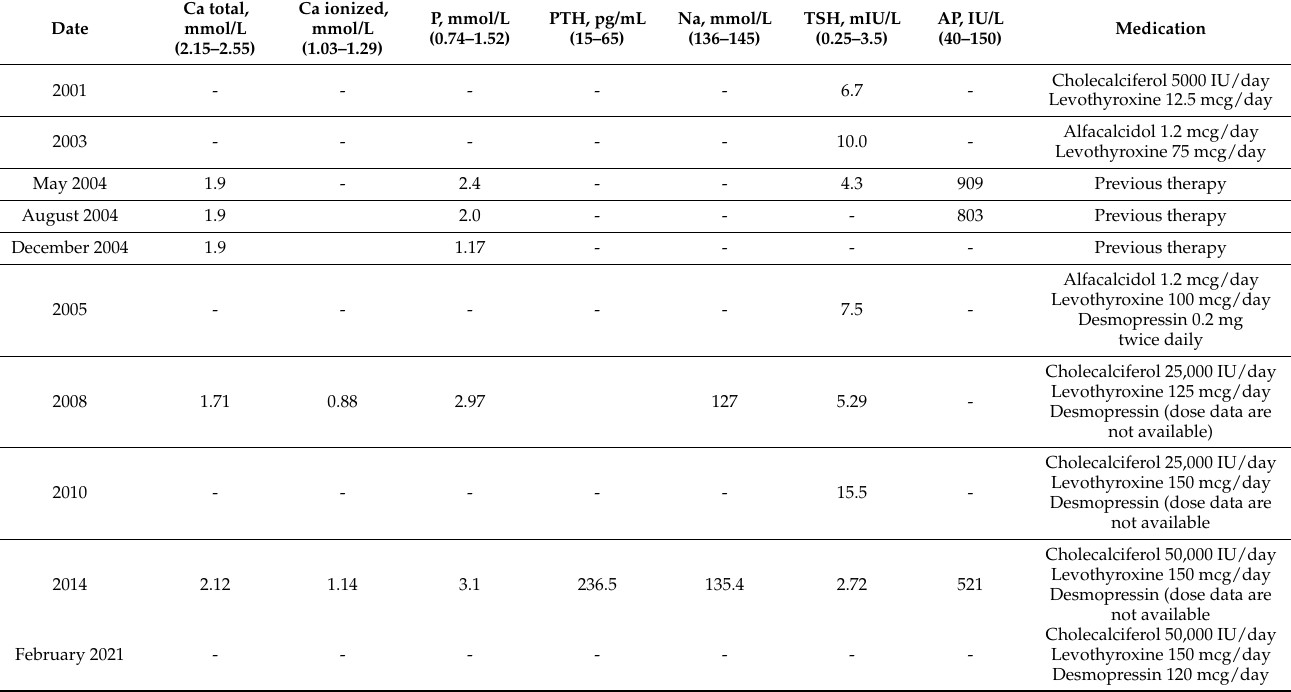
Table 1. Dynamics of laboratory parameters of patient T. PTH—parathyroid hormone, TSH—thyroid stimulating hormone, AP—alkaline phosphatase. References were taken according to the manufac- turers’